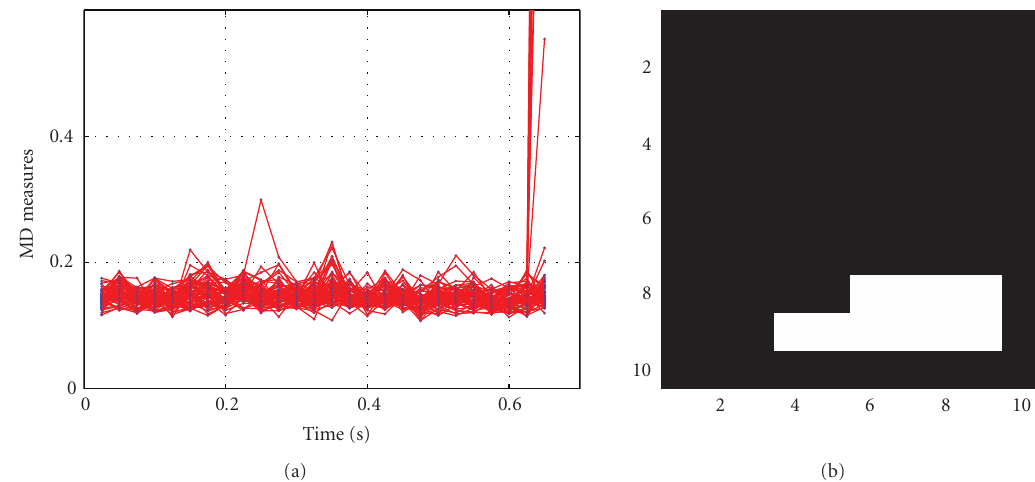
Figure 12: Distance measurements before 0.650 seconds: (a) manifold distance; (b) crude damage localization at t = 0.650 seconds, where the axis numbers mark the location of di ff erent subdomains shown in Figure 10(a).